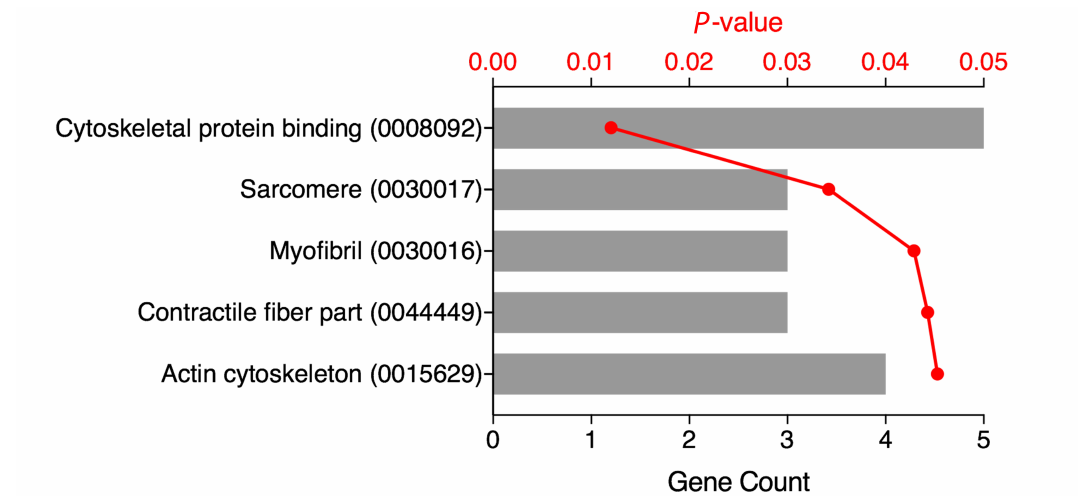
Figure 3. Functional Annotation. Gene Ontology (GO) terms and accession numbers (in parenthesis) for the top 50 differentially expressed genes (DAVID analysis, GO terms with Benjamini-adjusted P -values < 0.05) are shown with the number of genes (grey bar) and adjusted P -value